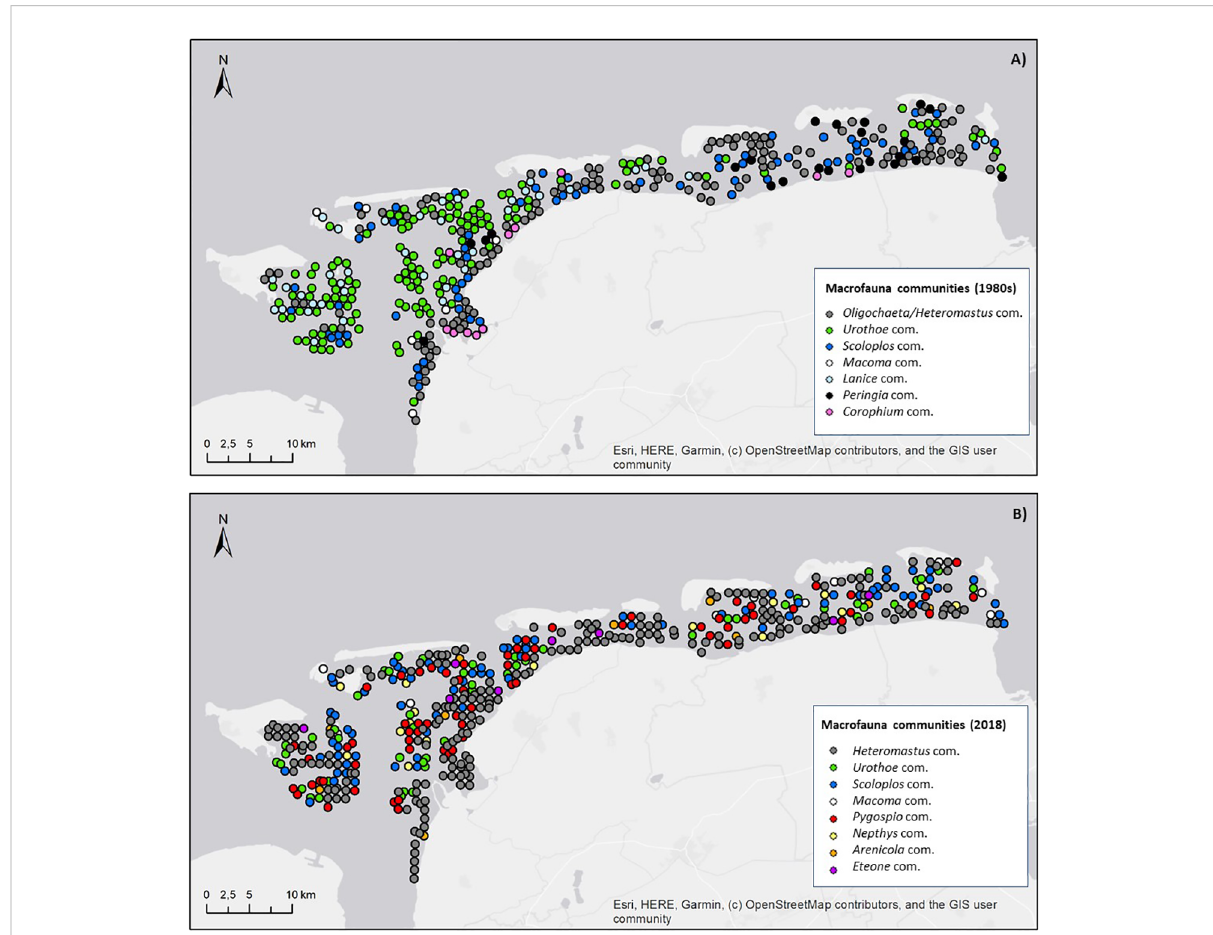
FIGURE 8 Spatial distribution of the macrofauna communities in the East-Frisian Wadden Sea, based on community analysis of the SENSI1 (1980s) and SENSI3 (2018) abundance data; (A) seven separated macrofauna communities for the 1980s and (B) eight separated macrofauna communities for 2018 (based on SIMPROF and cluster analysis, R package “ clustsig ” , version